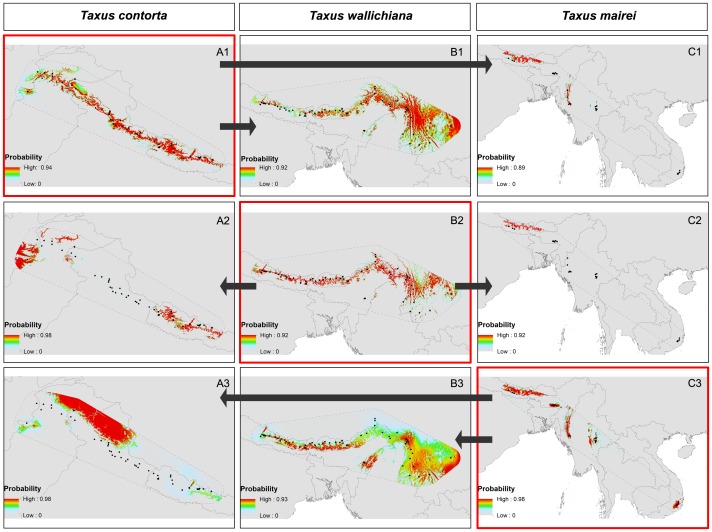
Ecological niche modeling.Comparison of species distribution models for A. T. contorta, B. T. wallichiana and C. T. mairei. The maps highlighted in red show the predictions for each species projected onto its own range: T. contorta (A1), T. wallichiana (B2), T. mairei (C3). The corresponding AUC values for these models are 0.948±0.023 SD (T. contorta), 0.958±0.018 SD (T. wallichiana) and 0.982±0.012 SD (T. mairei). The maps with a black margin show predictions for each species onto the range of another species: prediction of T. wallichiana (A2; AUC = 0.922) and prediction of T. mairei (A3; AUC = 0.774) onto the range of T. contorta; prediction of T. contorta (B1; AUC = 0.814) and prediction of T. mairei (B3; AUC = 0.786) onto the range of T. wallichiana; prediction of T. contorta (C1; AUC = 0.767) and prediction of T. wallichiana (C2; AUC = 0.932) onto the range of T. mairei. The AUC for these cross-model predictions are restricted to areas where the environment is within the range of the environments used for training the model.